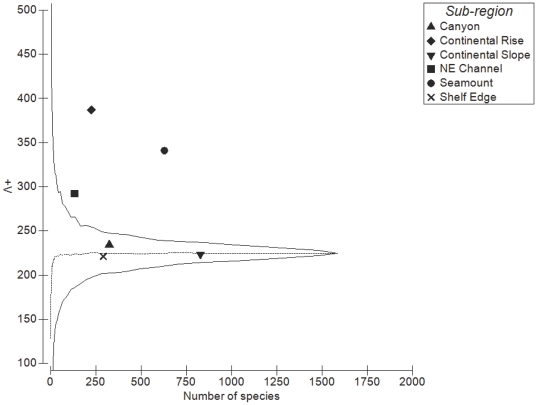
Variation in taxonomic distinctness (Λ+) by the number of species for each sub-region.Central line is variation in taxonomic distinctness for the total list. Funnel lines are confidence limits within which 95% of simulated values lie.